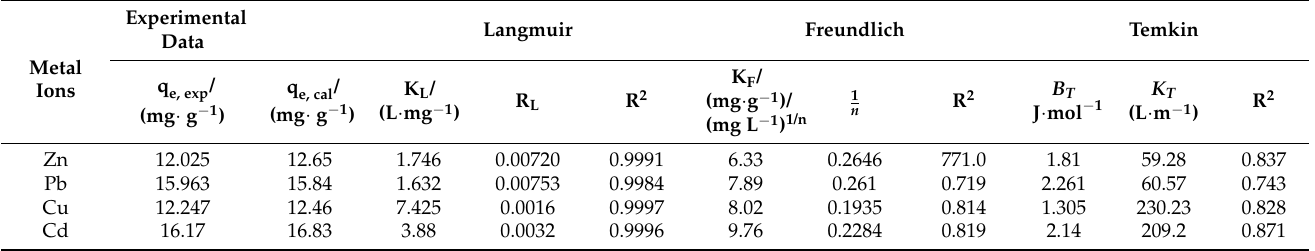
Table 4. Adsorption isotherm modeling for the metal ions adsorption onto synthesized Zeolite.